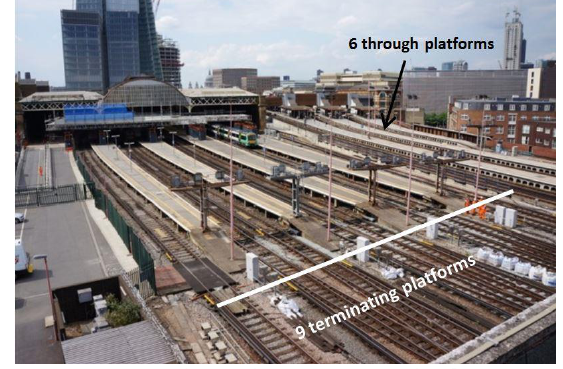
Figure 1 - London Bridge Station